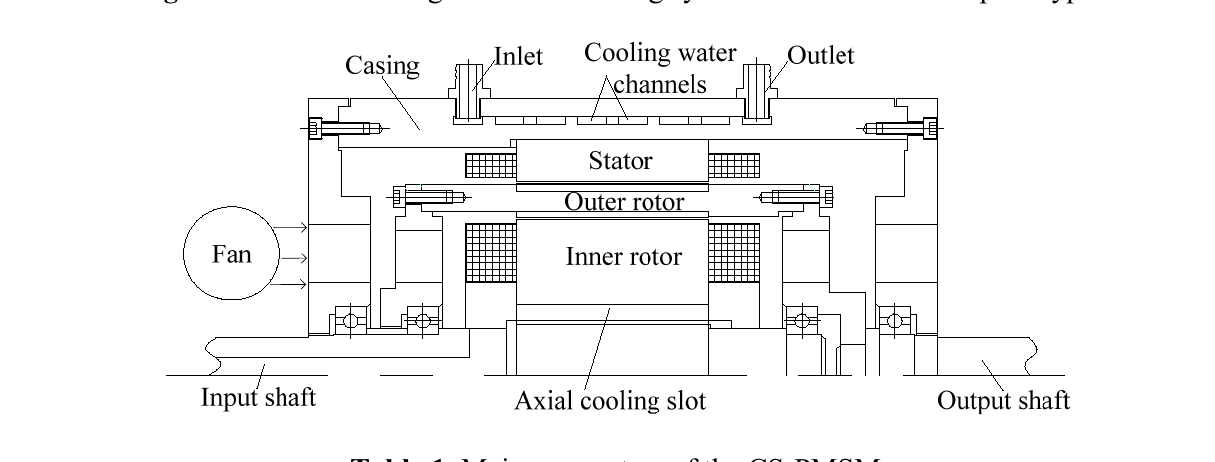
Figure 2. Schematic diagram of the cooling system of the CS-PMSM prototype.